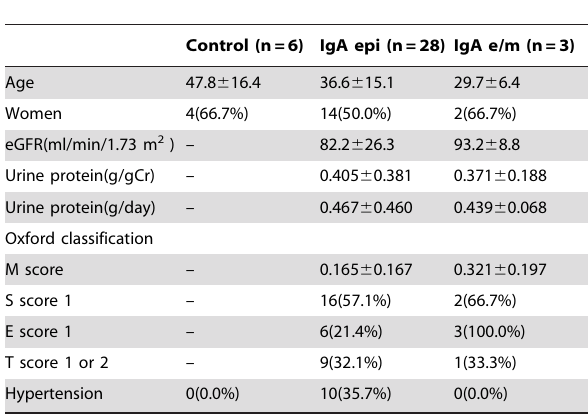
Table 1. Demographic, clinical parameters and pathological findings.